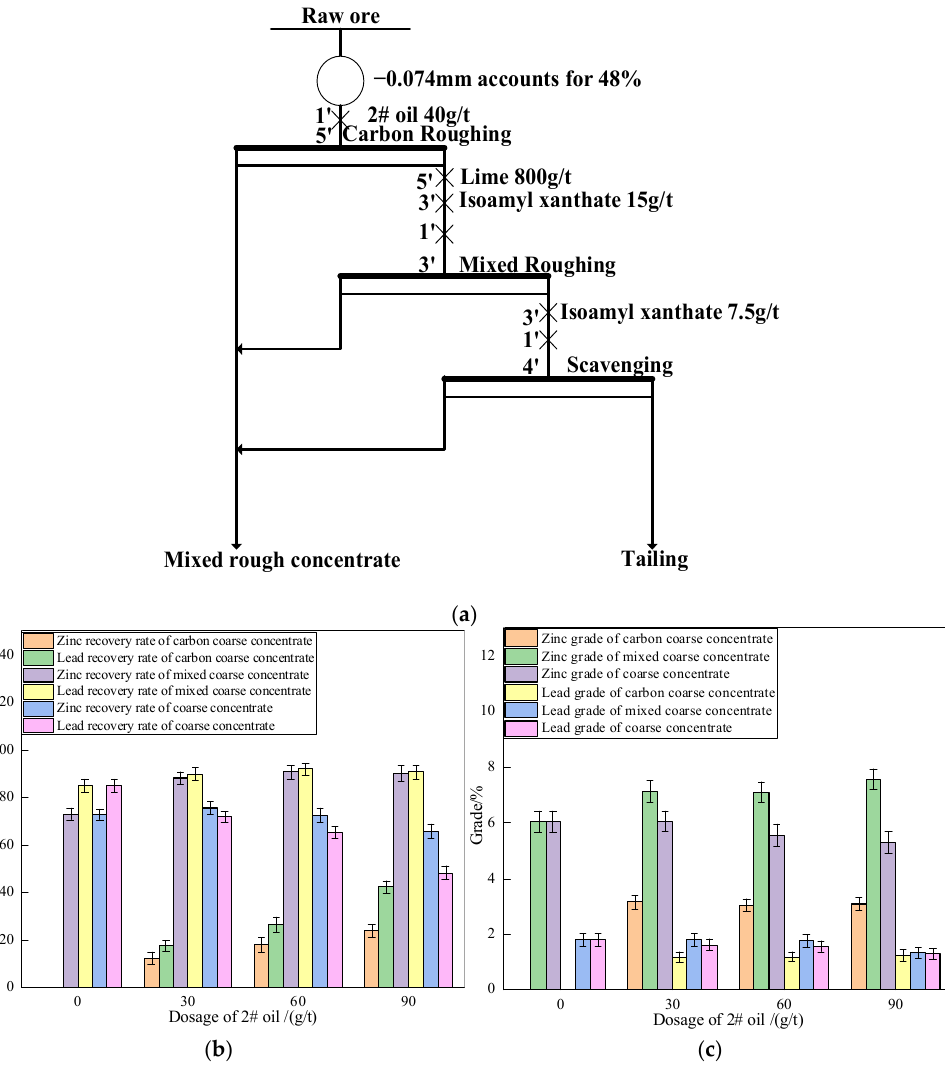
Figure 11. Effects of #2 oil dosage on the recovery rate of sulfide aggregates. ( a ) The flow chart for flotation experiments; ( b ) effects of 2 # oil dosage on the recovery rate of lead and zinc flotation; ( c ) effects of 2 # oil dosage on the grade of lead and zinc flotation.